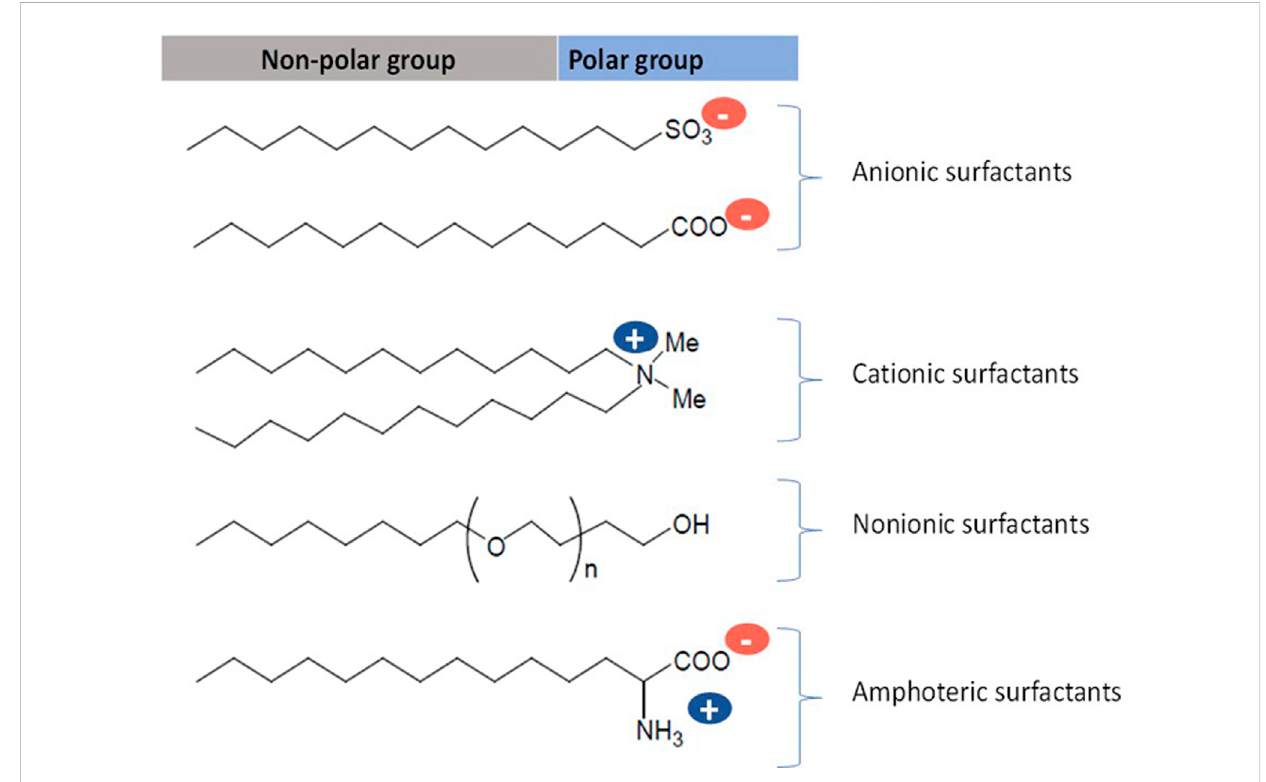
FIGURE 1 Classi fi cation of